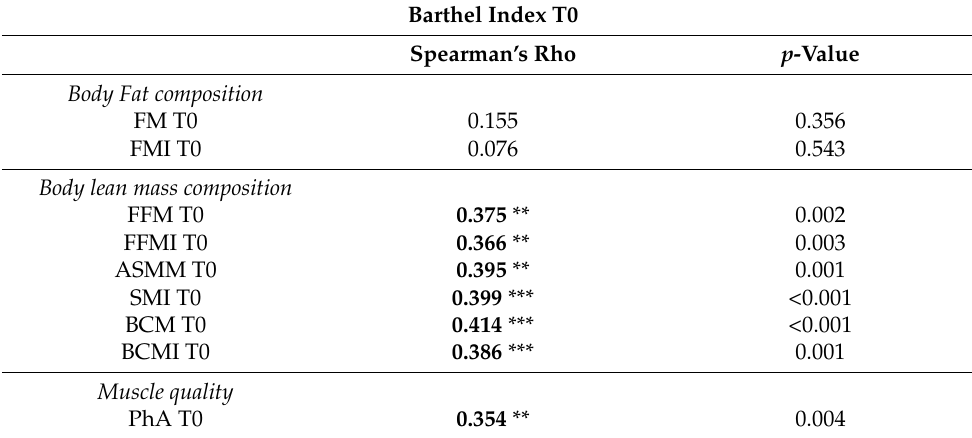
Table 3. Correlations between Barthel Index and body composition parameters measured by bioelec- trical impedance analysis (BIA) at admission (T0).